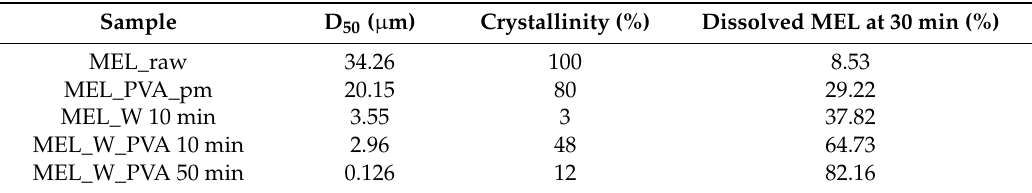
Table 6. Summarized information about the determined properties of the